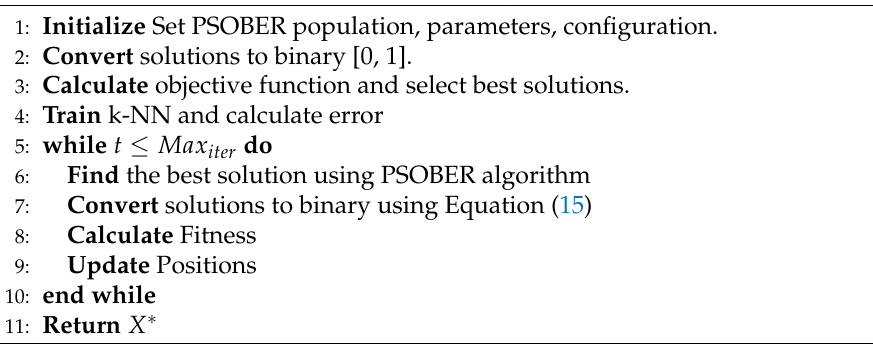
Algorithm 2 The proposed binary PSOBER